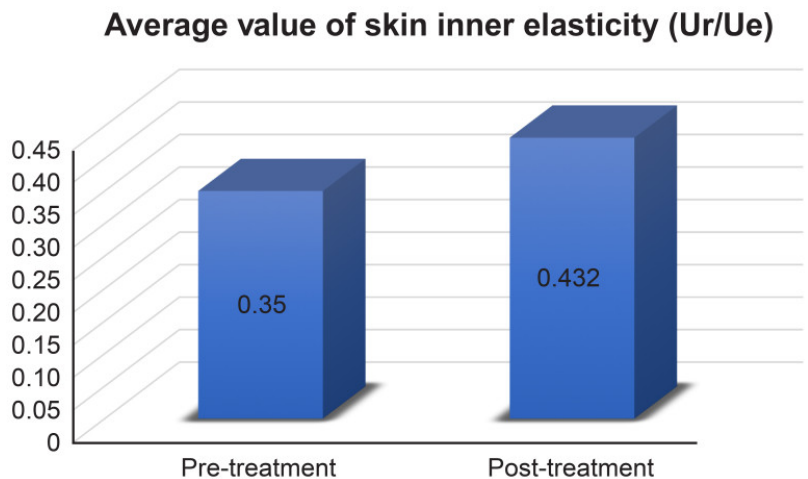
Figure 3. Average values of skin inner elasticity measurement results. Pre-treatment 0.3 ± 0.029, post-treatment 0.432 ± 0.06.